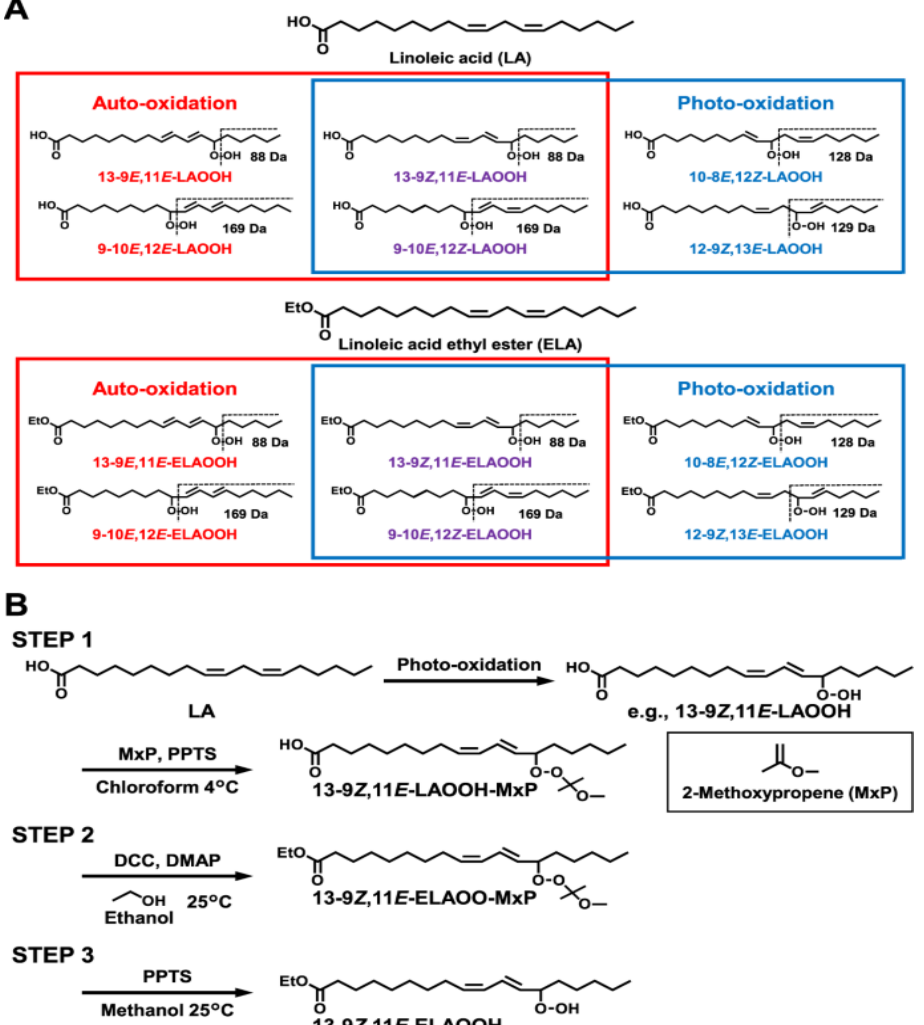
Figure 1. The chemical structures of six isomers of linoleic acid and linoleic acid ethyl ester depending on the type of oxidation (photo-oxidation or auto-oxidation) (A). The preparation schemas of linoleic acid ethyl isomers (B). ( 13-9 E. 11 E-LAOOH; 9-10 E. 12 E-LAOOH; 13-9Z. 11 E- LAOOH; 9-10 E. 12 Z-LAOOH; 10-8 E. 12 Z-LAOOH and 12-9 Z. 13 E-LAOOH). and six isomers of ELAOOH (9-10 E. 12 Z-ELAOOH; 9-10 E. 12 E-ELAOOH; 10-8 E. 12 Z-ELAOOH; 12-9 Z. 13 E-ELAOOH; 13- 9 Z. 11 E-ELAOOH and 13-9 E. 11 E-ELAOOH